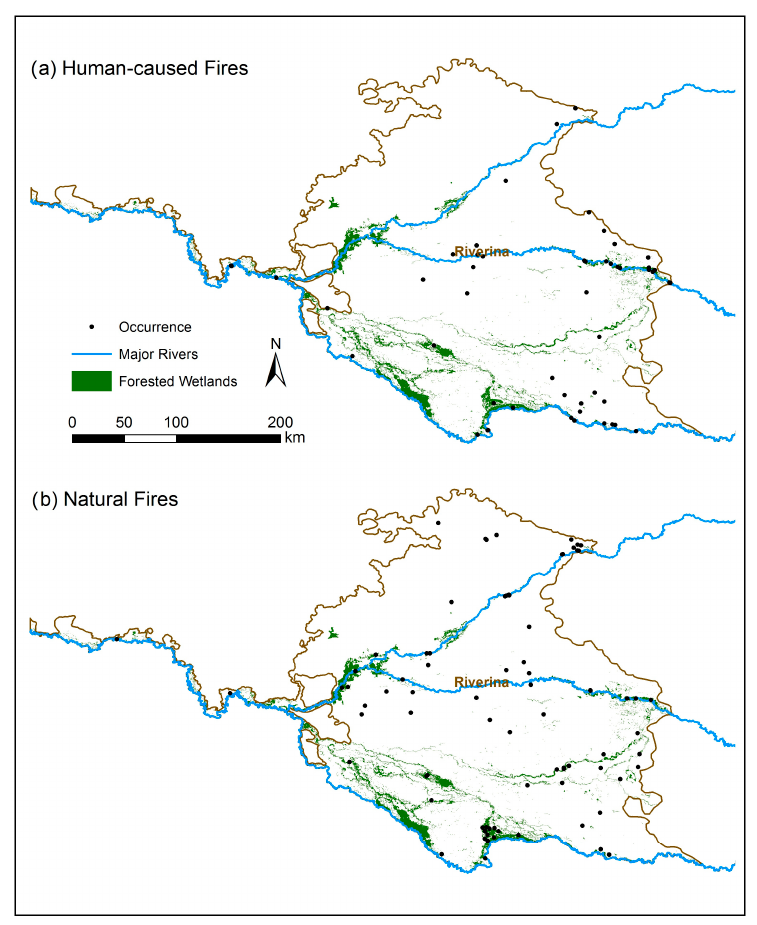
Figure 1. Location of the Riverina Bioregion and distributions of ( a ) human-caused and ( b ) natural fires (fire polygons are represented by their centroid points).